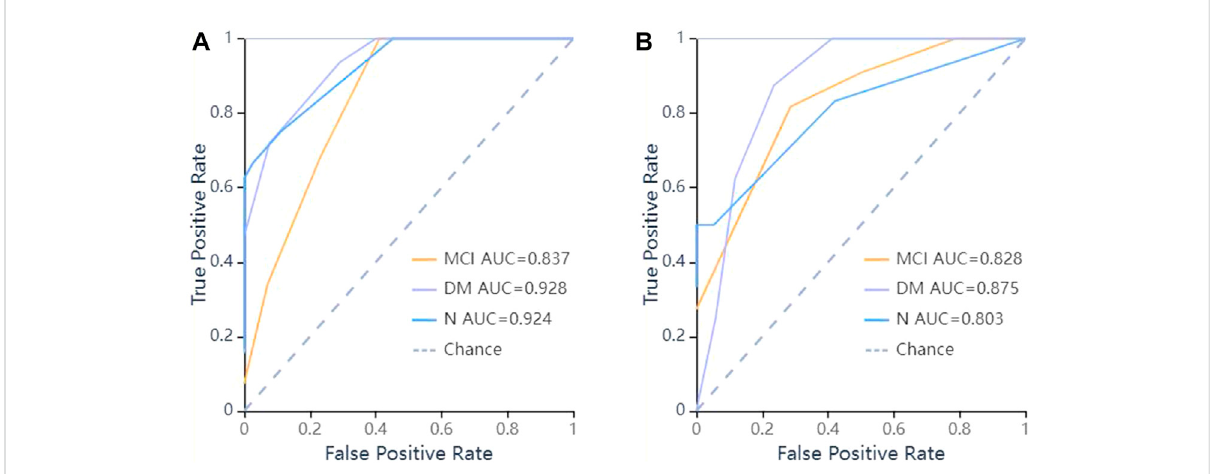
FIGURE 7 ROCcurvesofKNNmethodsto classi fi cation. (A) ROC curveoftraining set,theAUCwere0.928 inDM(sensitivity andspeci fi citywere0.78and {"MCI ” : 0.75, “ DM ” : 0.83, “ N": 0.97}), 0.837 in MCI (sensitivity and speci fi city were 0.71 and {"MCI ” : 0.75, “ DM ” : 0.83, “ N": 0.97}), 0.924 in N (sensitivity and speci fi city were 0.67 and {"MCI ” : 0.75, “ DM ” : 0.83, “ N": 0.97}) respectively; (B) ROC curve of validation set, the AUC were 0.875 in DM (sensitivity andspeci fi citywere0.75and{"MCI ” :0.71, “ DM ” :0.88, “ N": 0.95}),0.828 inMCI (sensitivity andspeci fi citywere0.82 and{"MCI ” :0.71, “ DM ” :0.88, “ N": 0.95}), 0.803 in N (sensitivity and speci fi city were 0.50 and {"MCI ” : 0.71, “ DM ” : 0.88, “ N": 0.95}) respectively.